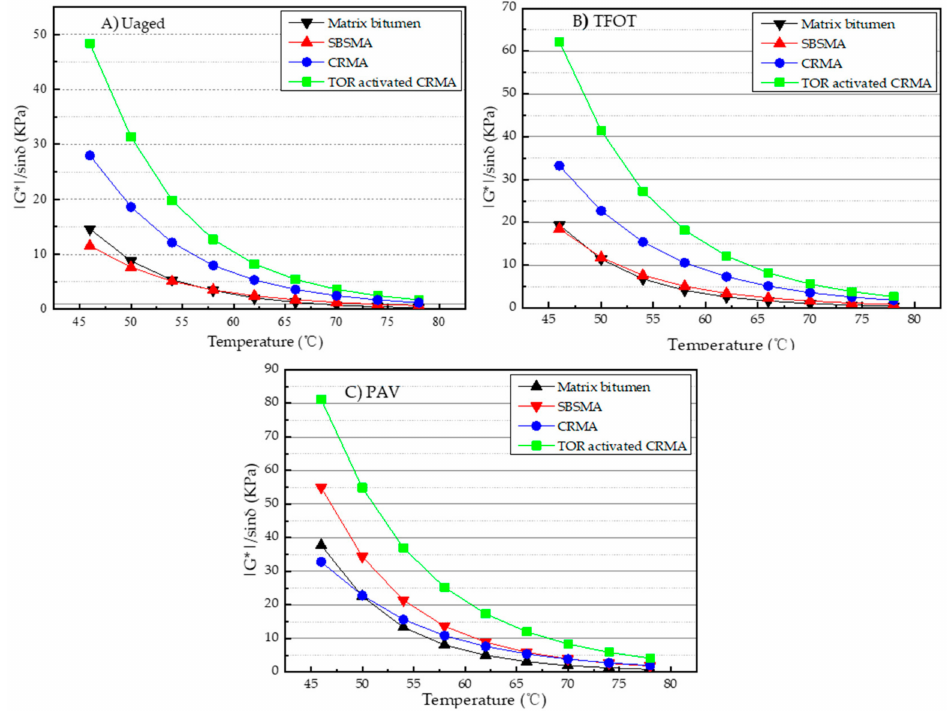
Figure 9. The | G* |/ sin δ of four samples before and after aging. ( A ) Unaged; ( B ) after TFOT; ( C ) after